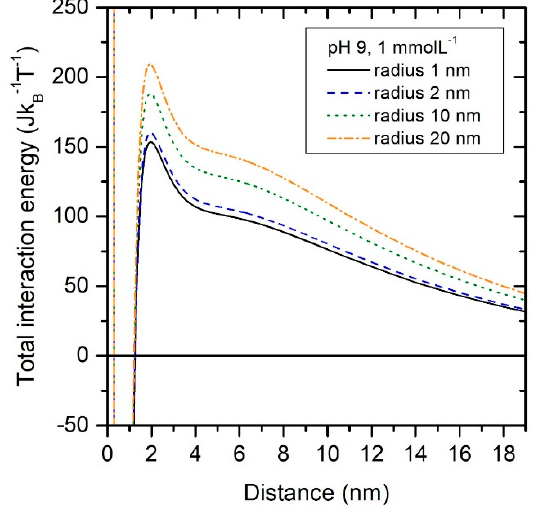
Figure 9. Variation of the edge radius in DLVO calculations. The best fit surface potential of FEBEX bentonite colloids (see Figure 6b) and the estimated edge electrokinetic potential of α -alumina (see Figure 7a) at pH 9 and a background electrolyte concentration of 1 mmol L − 1 are used.